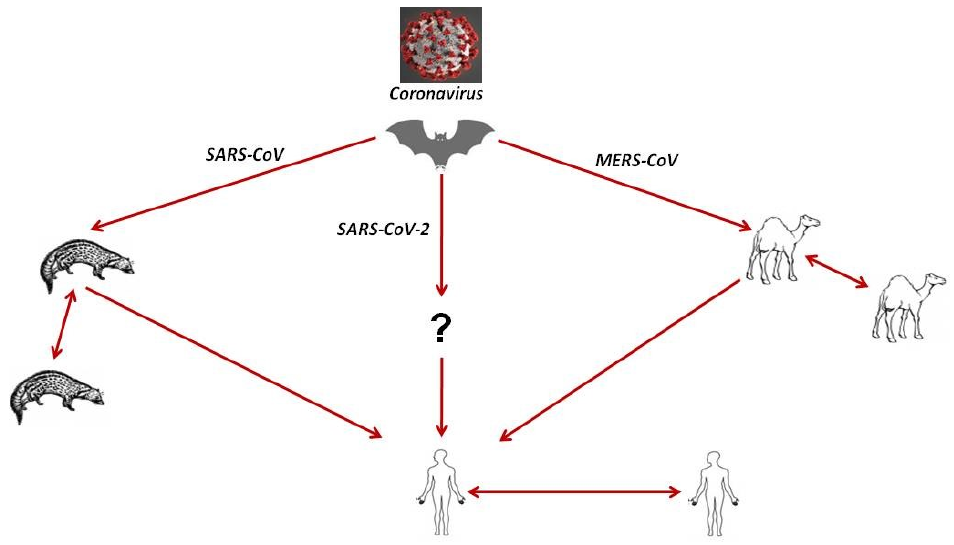
Figure 3. The transmission cycle of coronaviruses including MERS-CoV, SARS-CoV, and SARSCoV-2. The transmission of the virus to humans occurs by direct contact with infected animals. The continuous line represents direct transmission. line represents direct